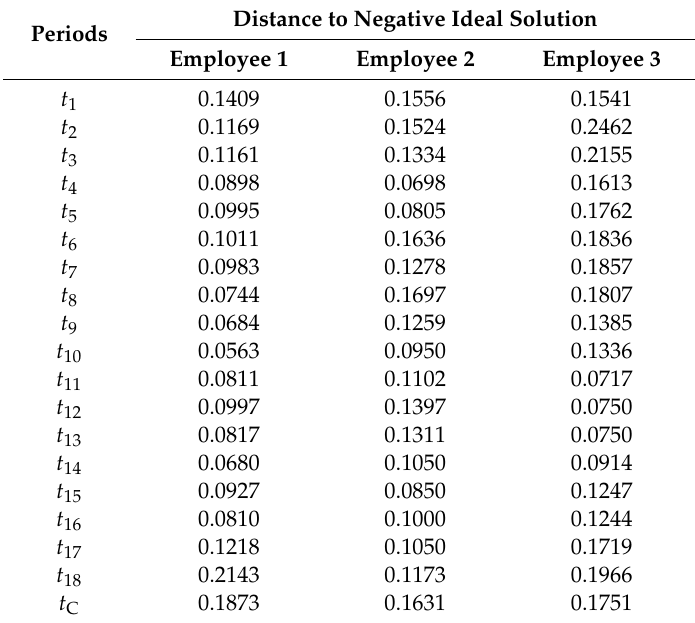
Table 12. Distances between the performance of employees and the negative ideal